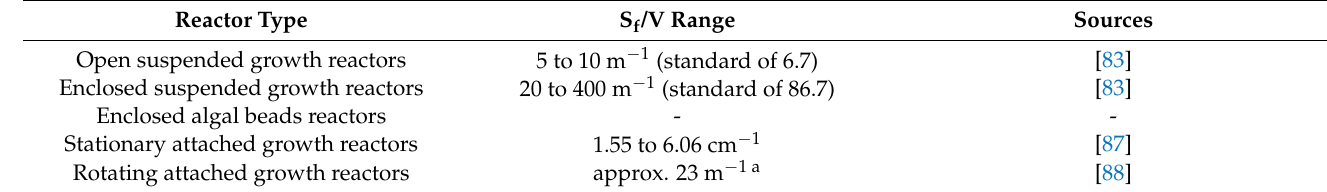
Table 2. Sf/V ratios of the main branches of algae-based wastewater treatment reactors.